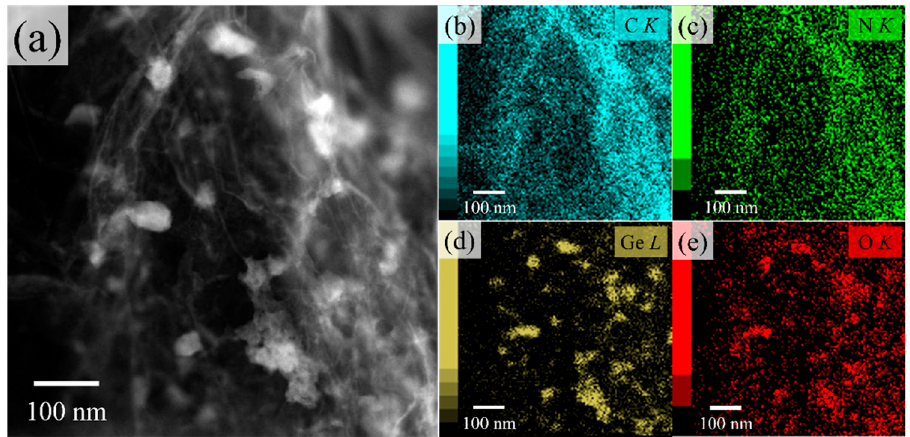
Figure 7. ( a ) HAADF-STEM image and EDS mapping images of element distribution corresponded to ( b ) C, ( c ) N, ( d ) Ge, and ( e ) O signals.